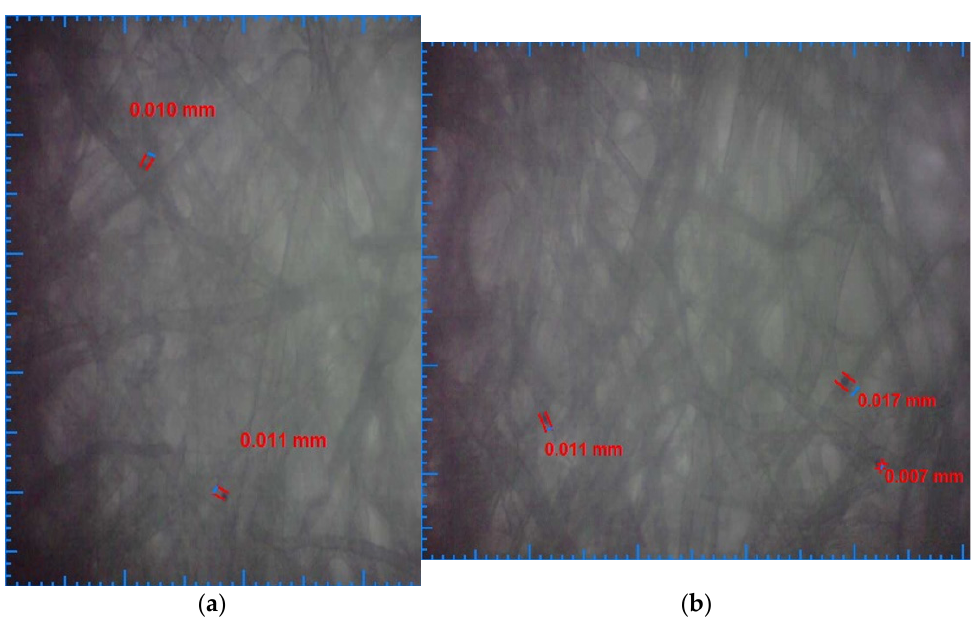
Figure 5. ( a ) Polypropylene filter water deposits sample; ( b ) activated carbon filter water deposits sample.